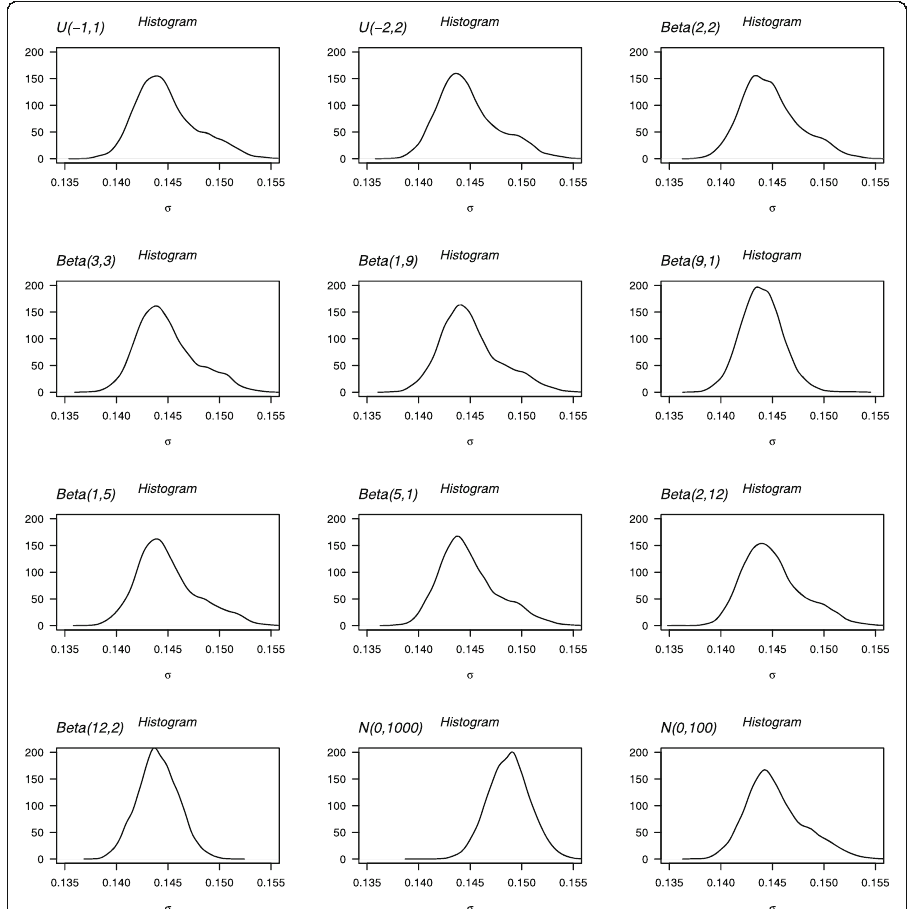
Fig. 16 Prior sensitivity analysis: marginal posterior densities for σ in the validating forecasts for Danish women of our model using different prior specifications. We use the Uniform, the Beta, and the Normal distribution with different parameter values to determine various levels of their location and spread. Despite these different prior specifications, the resulting marginal posterior densities are (very)